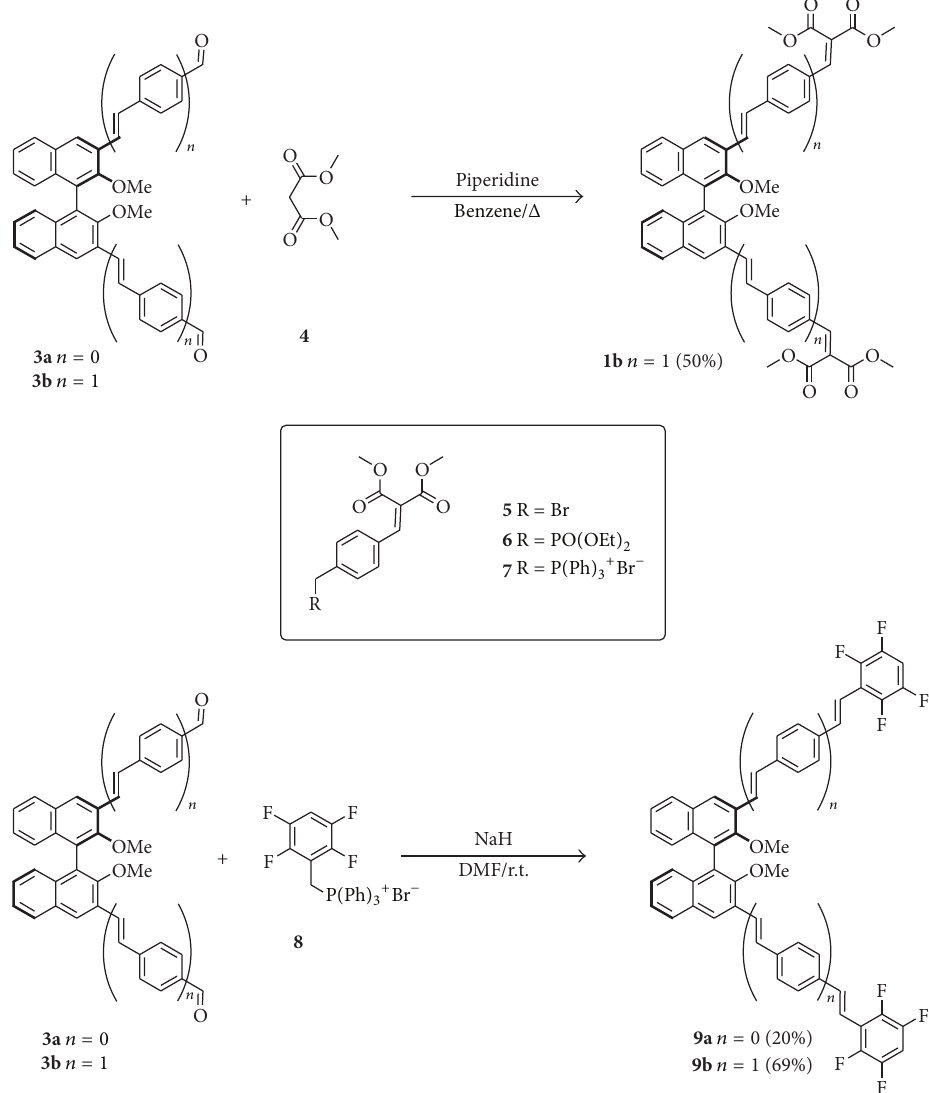
Scheme 1: Synthesis of the molecular modules described in this